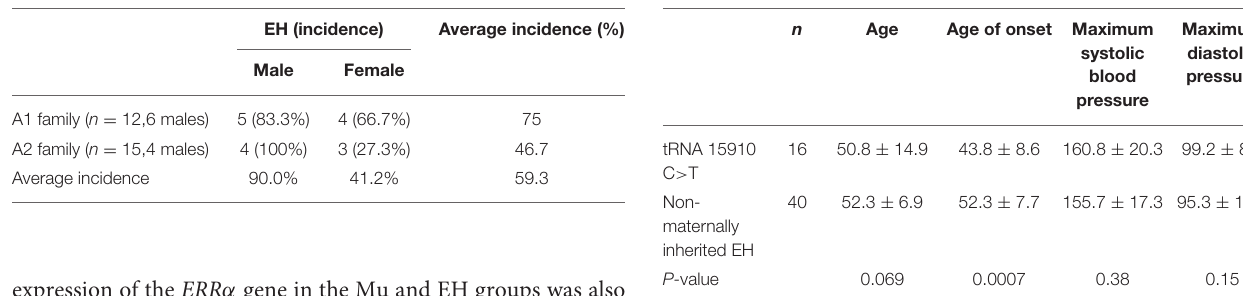
TABLE 2 | Incidence of EH in adult matrilineal members of tRNA 15910 C > T family.